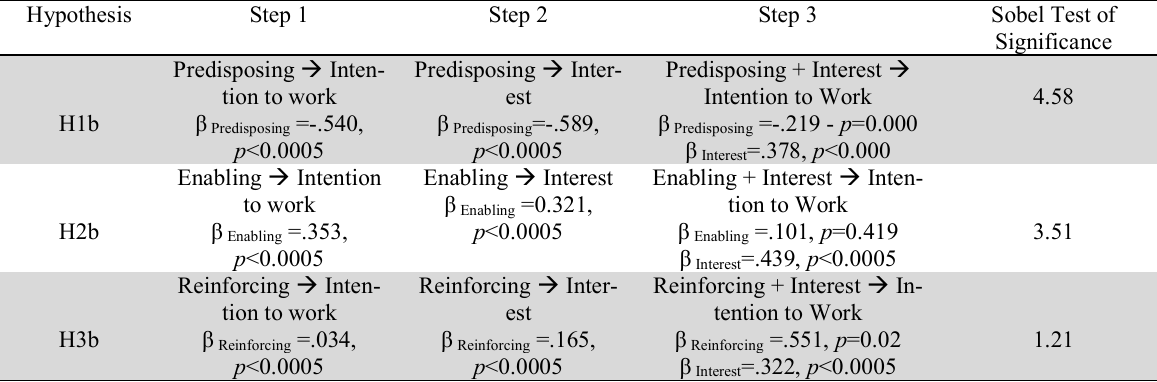
Results of the Mediating